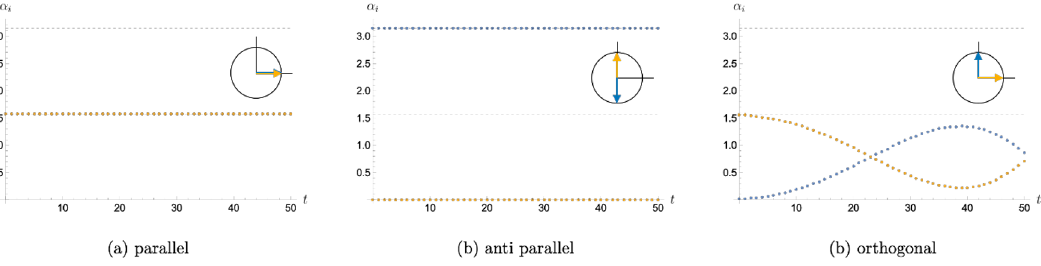
Figure 18 . Time evolution of the internal orientations for the parallel, antiparallel and orthogonal cases, for parameters ( m χ /m φ , m γ /m φ ) = (0 . 05 , 0 . 3) or more explicitly ( v = 5 , λ = 1 / 4 , e = √ 3 / 10 2 , Ω = 1 / 4